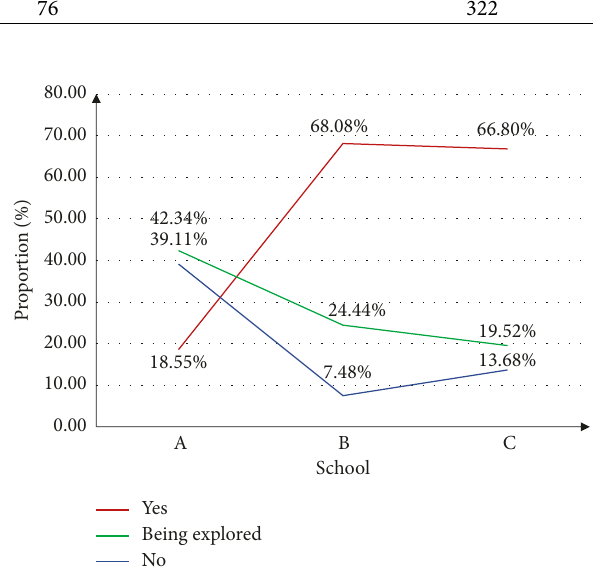
Figure 7: Whether physical education students have innovated their learning methods.